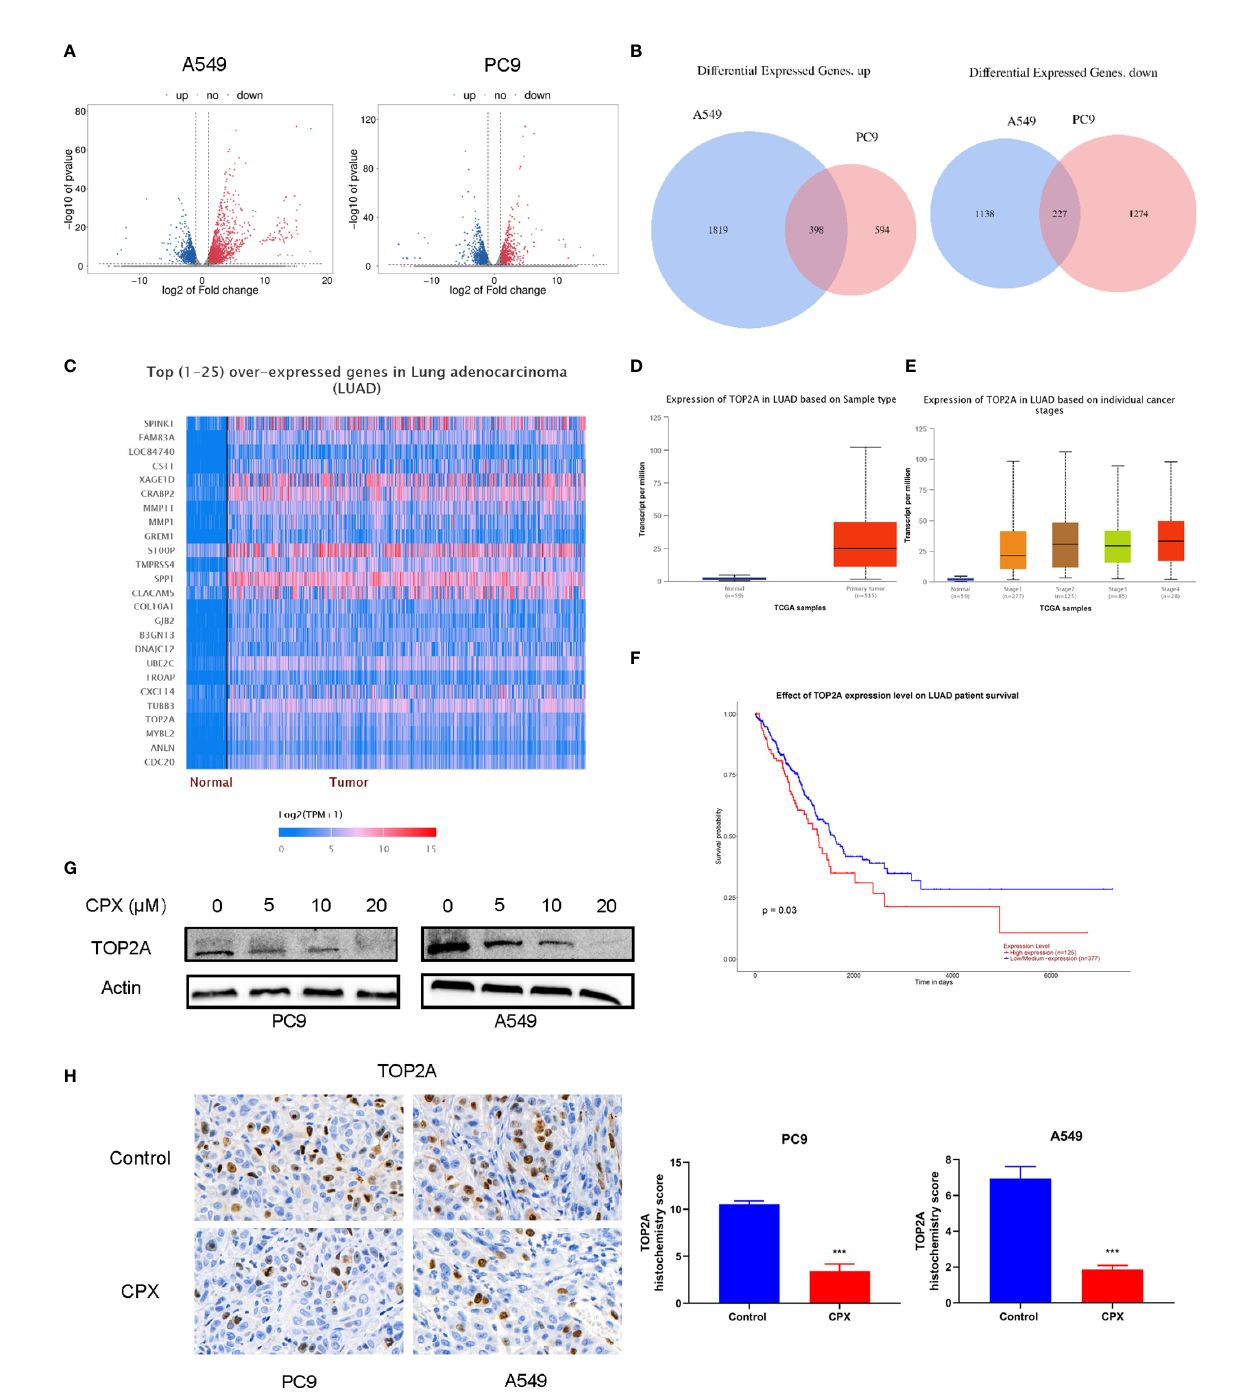
FIGURE 6 | CPX down-regulates TOP2A in LUAD. (A) Volcano plot analysis of DEGs in A549 and PC9 cells treated with or without 20 m M CPX for 24 hours. Red areas indicate signi fi cant overexpression, green areas indicate signi fi cant down-regulation, and grey areas indicate non-signi fi cant changes. (B) Venn diagram intersections show up-or down-regulated DEGs in A549 and PC9 cells. (C) Heatmap of the top (25) over-expressed genes in LUAD (UALCAN). (D) A box plot showing TOP2A expression in LUAD (UALCAN). (E) Box plot showing TOP2A expression at different tumor stages among LUAD patients (UALCAN). (F) Kaplan- Meier plot showing the effects of TOP2A expression levels on LUAD patient survival (UALCAN). (G) . Western blotting showing TOP2A expression in LUAD cells pretreated with indicated CPX concentrations for 24 hours. (H) . TOP2A immunohistochemistry staining in xenograft tumors in different groups (magni fi cation 400×). ***P < 0.001. Statistical signi fi cance compared with respective control